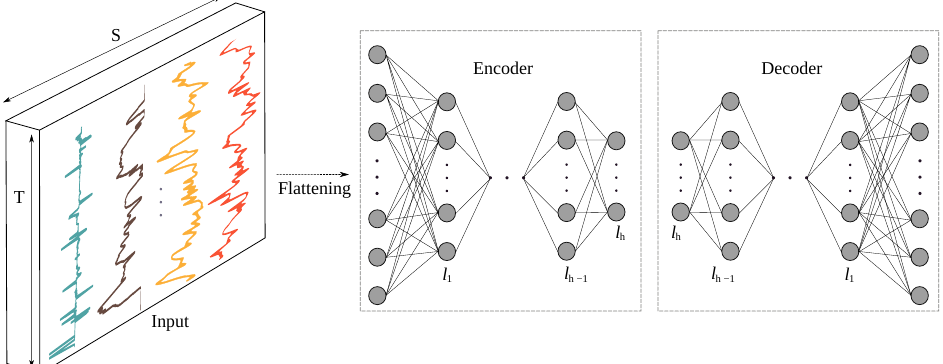
Figure 6. Autoencoder’s architecture used for accident detection consists of encoder and decoder sections. The encoded layer is used as features for the feature learning purposes; S is the number of sensor channels and h denotes the number of hidden layers in both the encoder and